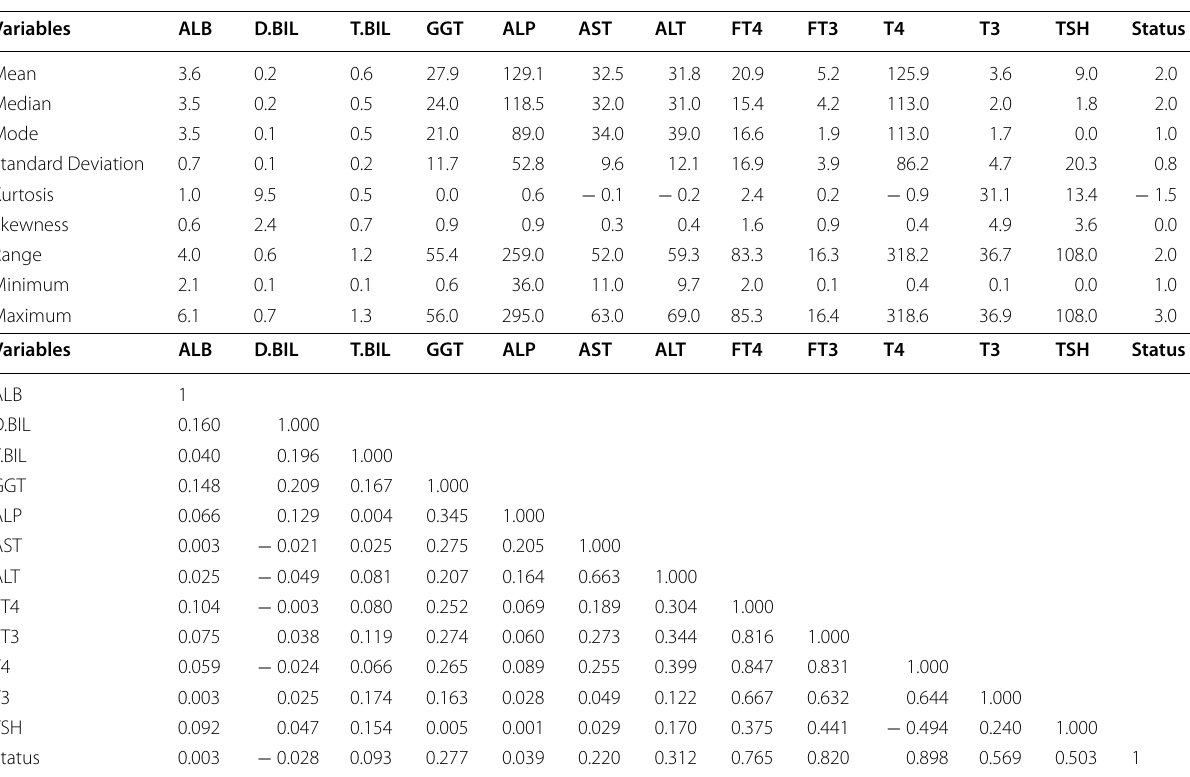
Table 1 Basic descriptive statistics and Spearman–Pearson correlation analysis